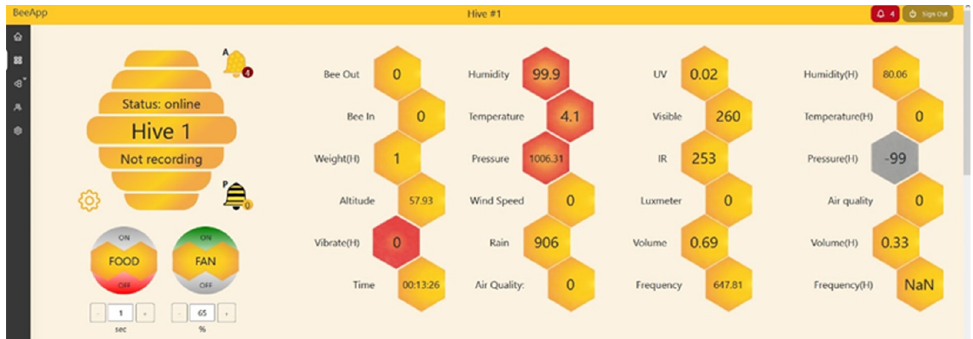
Figure 5. Application interface.